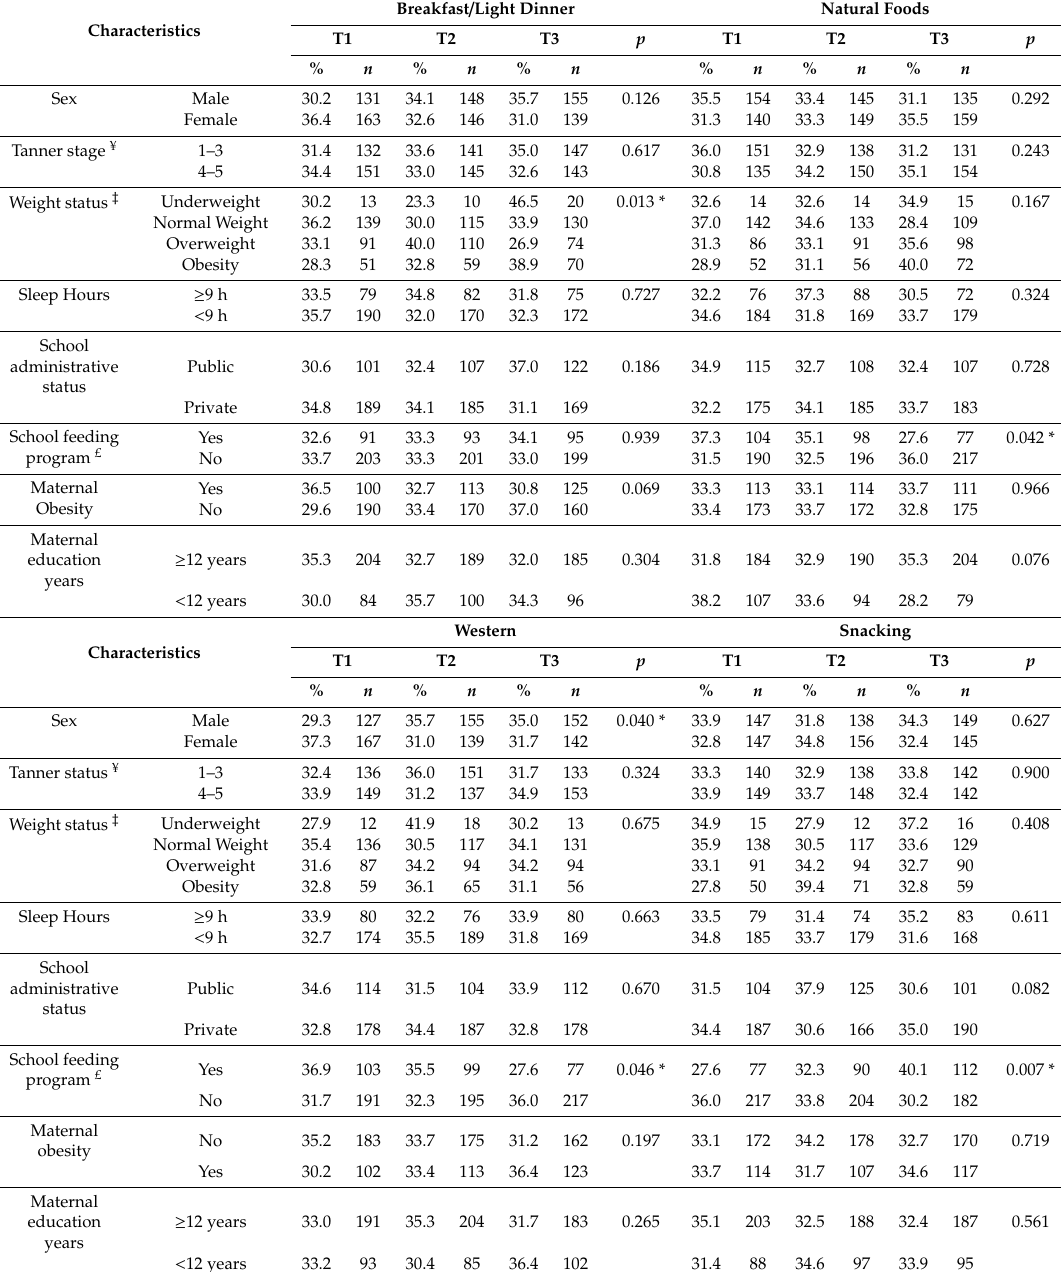
Table 3. Adherence (%) according to sociodemographic, anthropometric, and maternal nutrition status of 882 Chilean adolescents, GOCS Study 2014–2015